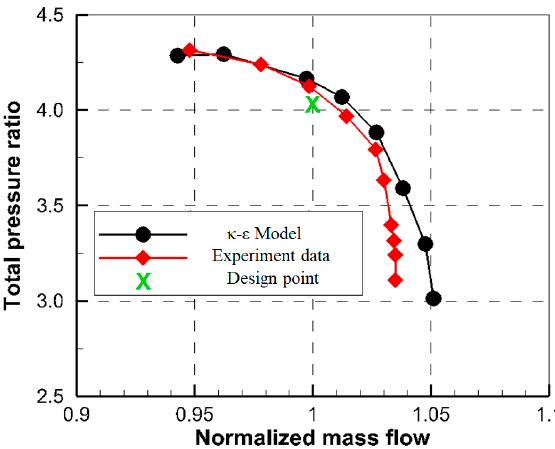
Figure 5. Comparison between numerical simulation results and experimental data.